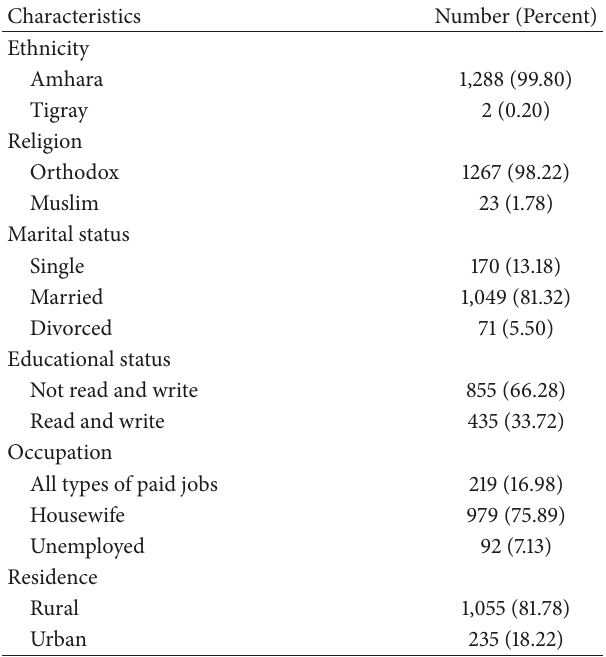
Table 1: Sociodemographic characteristics of pregnant mothers at DHDSS site, northwest Ethiopia, 2014-2015.